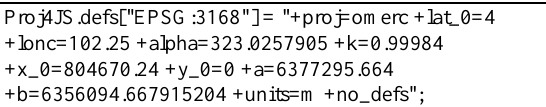
Figure 6. The Dun Melaka Using Higher Zoom